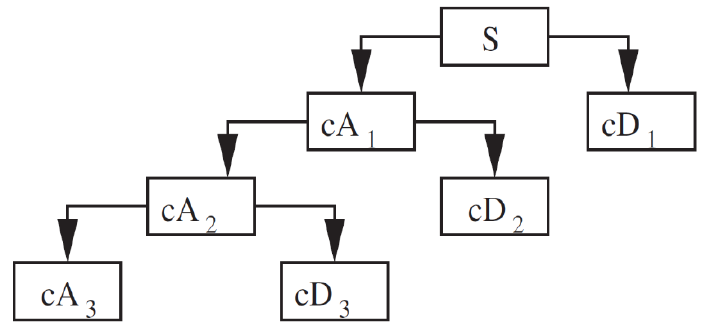
Figure 1. Discrete wavelets transform the decomposition tree.